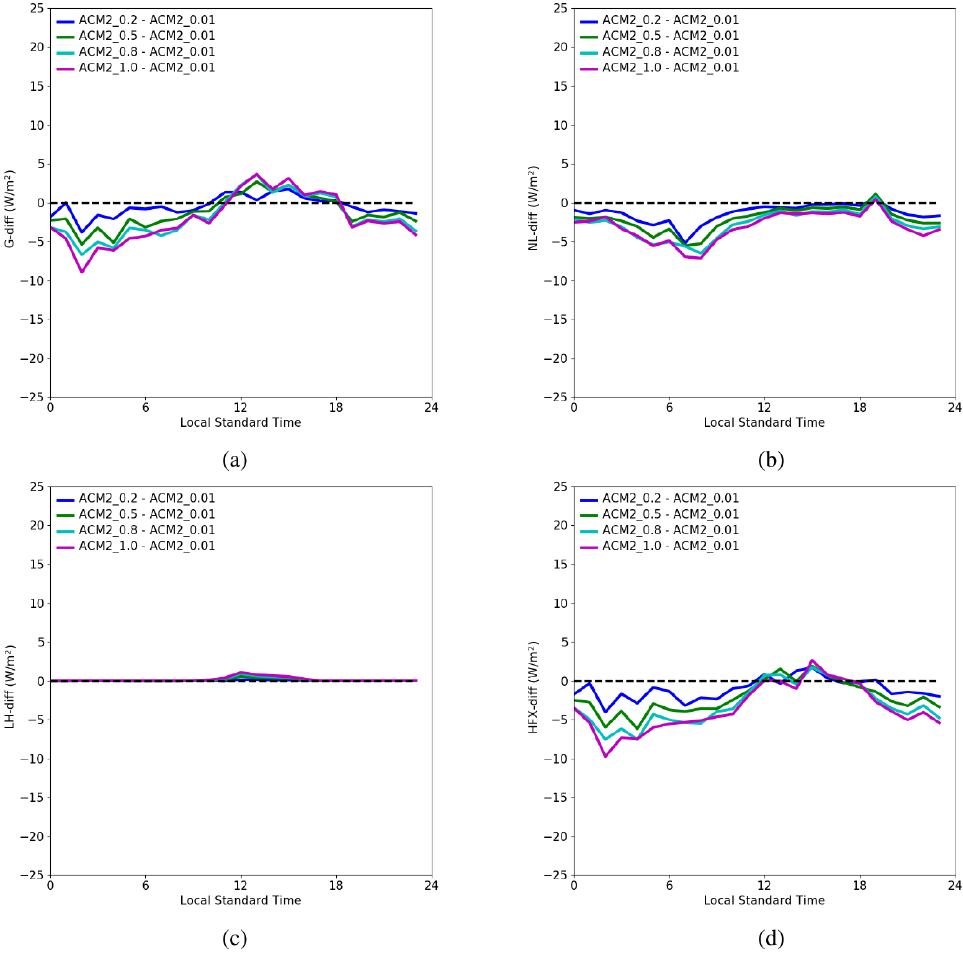
Figure 3. Diurnal mean time series of deviations (based on ACM2_0.01) in (a) the ground heat flux G , (b) the net longwave radiation flux NL, (c) the latent heat flux LH , and (d) the sensible heat flux HFX at the